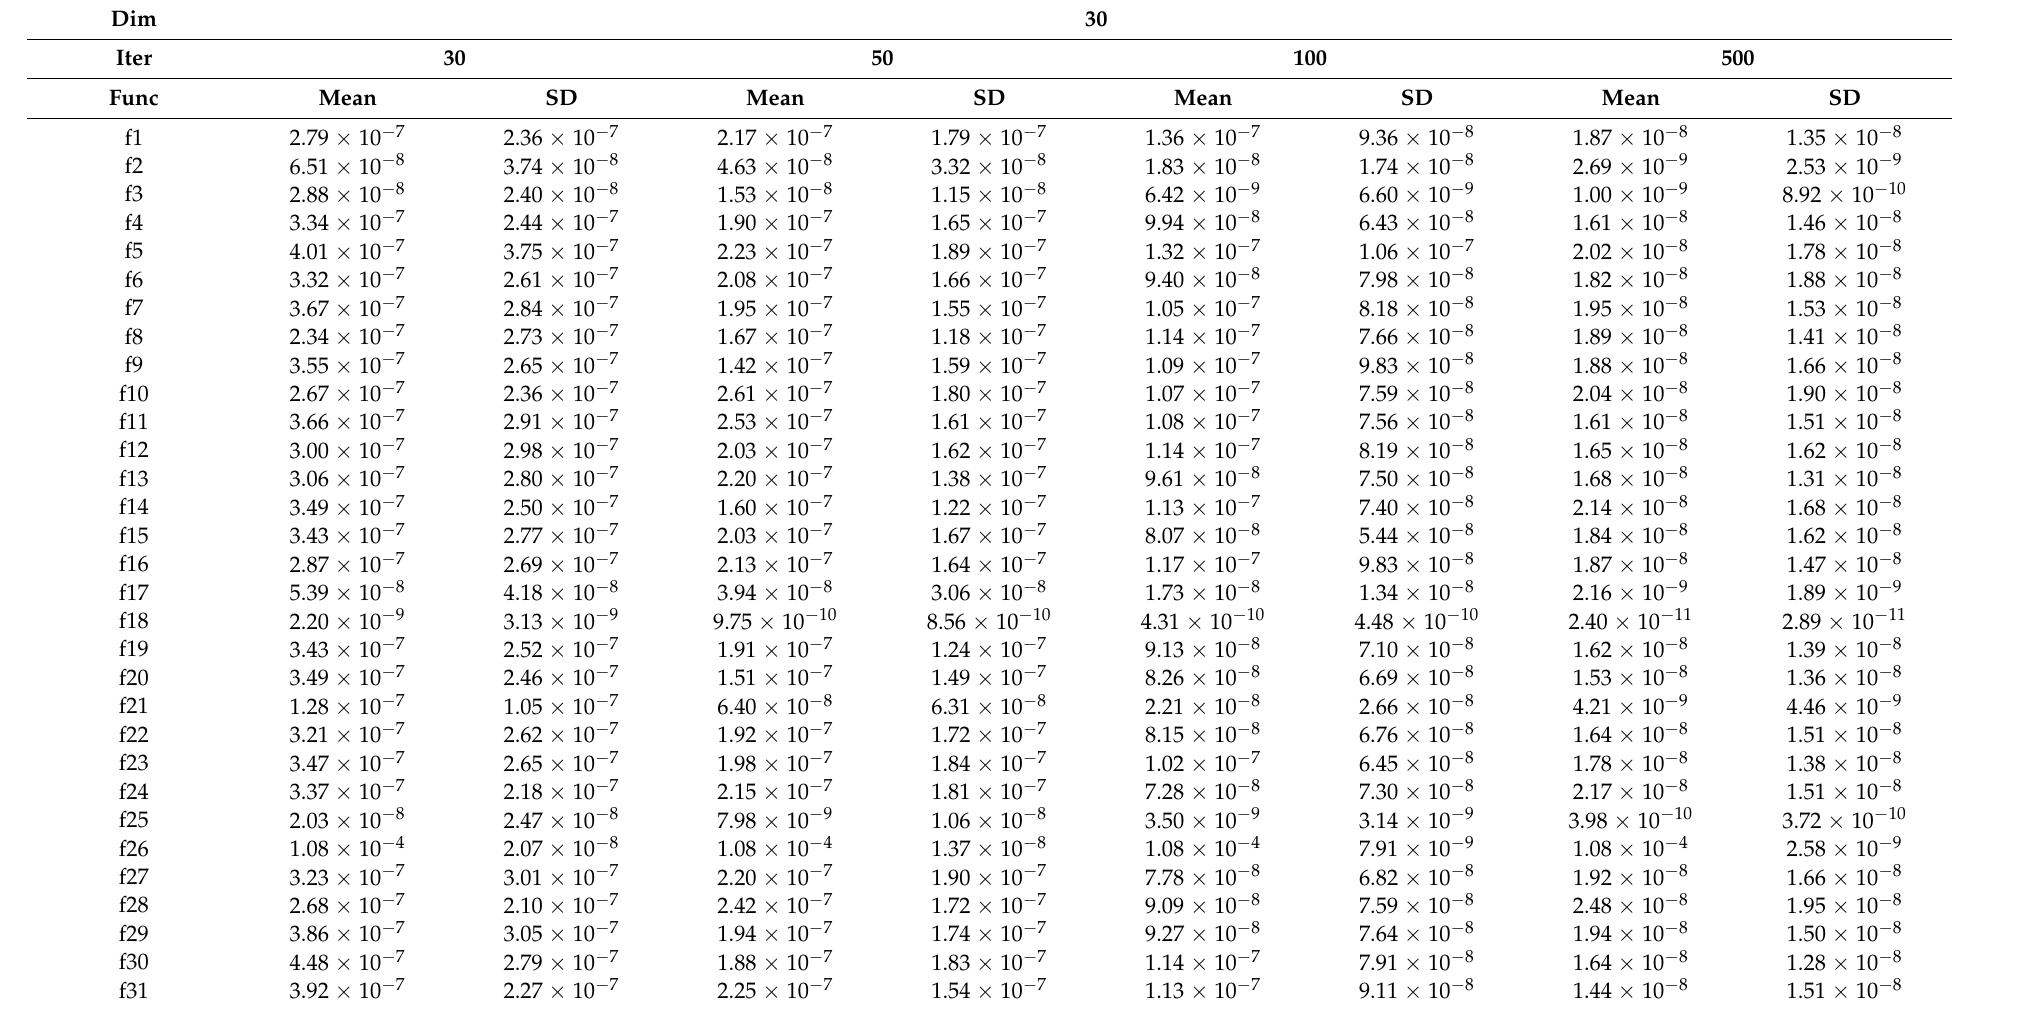
Table 7. DMOA: Results of the experiments for 30